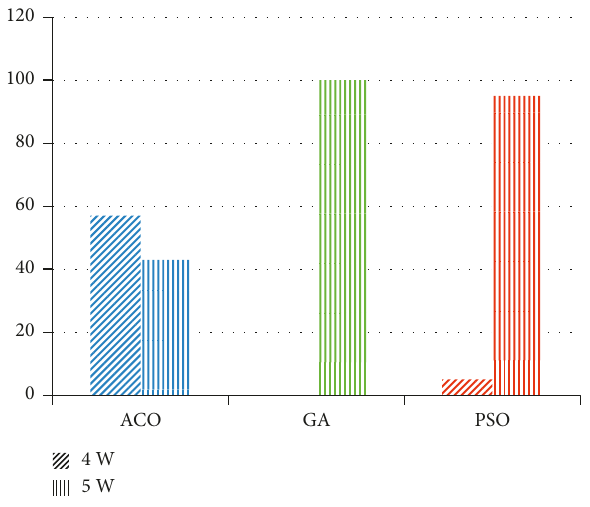
Figure 4: PDF of power